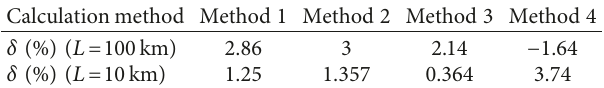
Table 7: Influence of the transient resistance on the error of average fault location result, l real